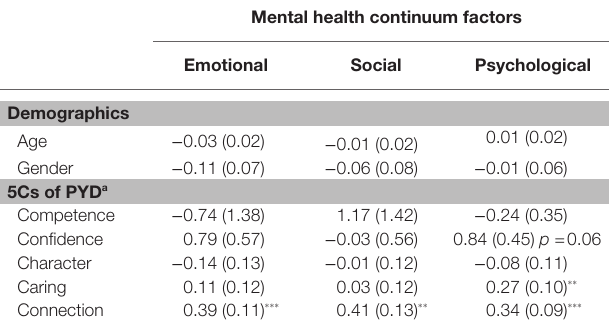
TABLE 4 | Summary of the confirmatory factor analysis for the best fitting model of the Mental Health Continuum – factor loadings and correlations. MHC factor